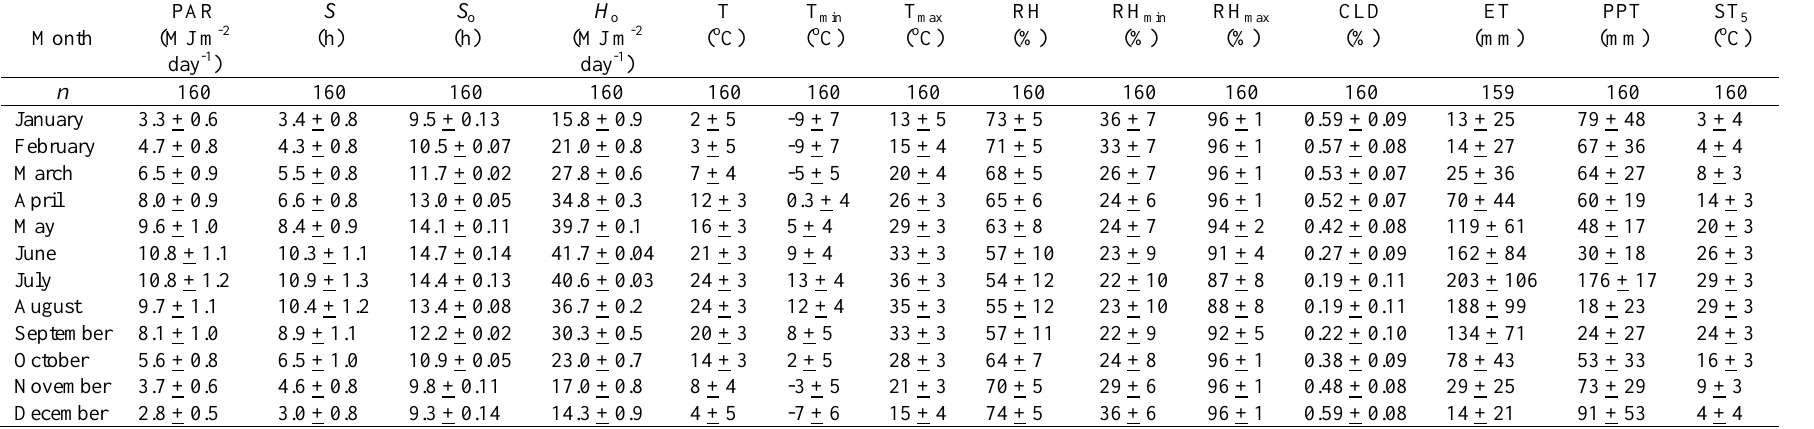
Table 1. Mean (+ SD) values of climate data observed at 160 climate stations in